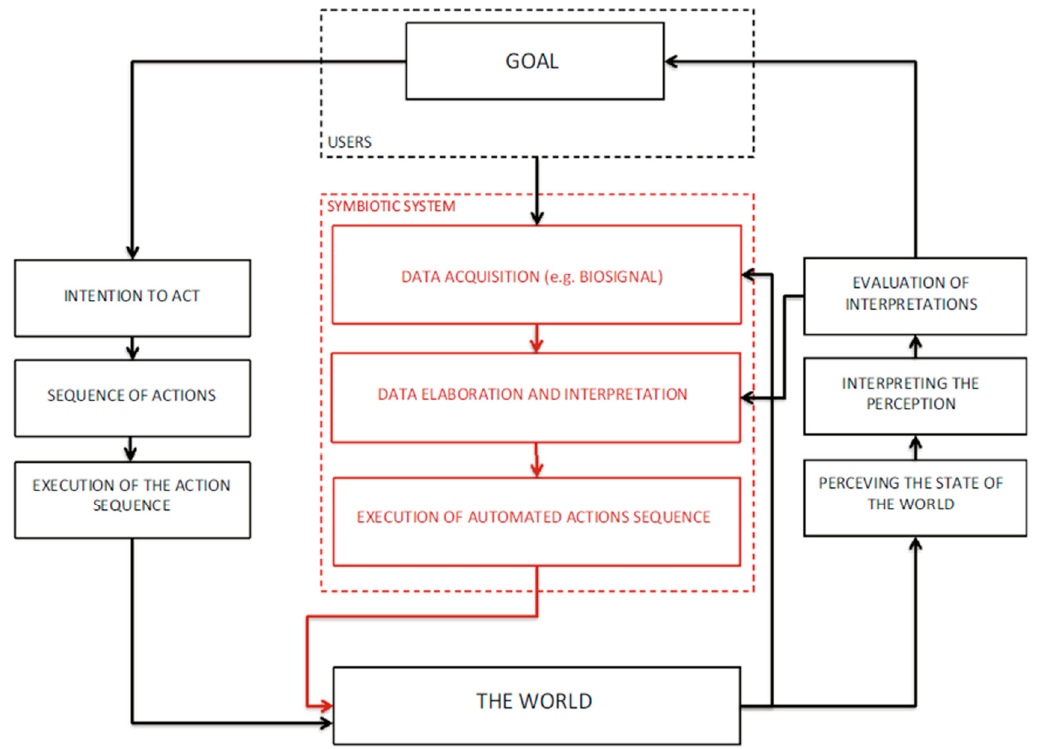
Figure 1. Model of a symbiotic system.